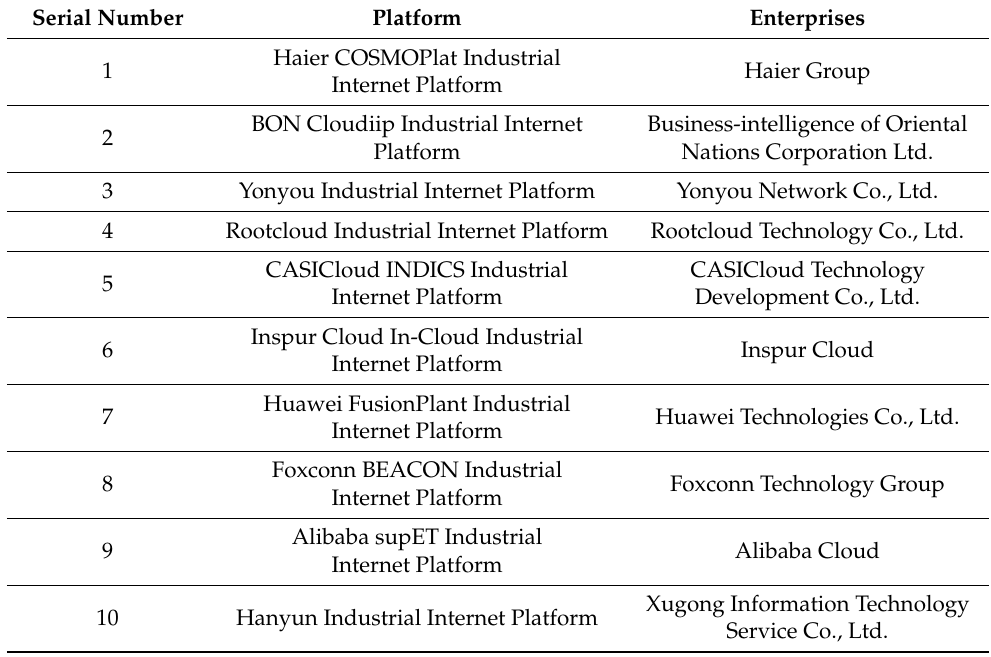
Table 4. Development Index Series and Description of Industrial Internet